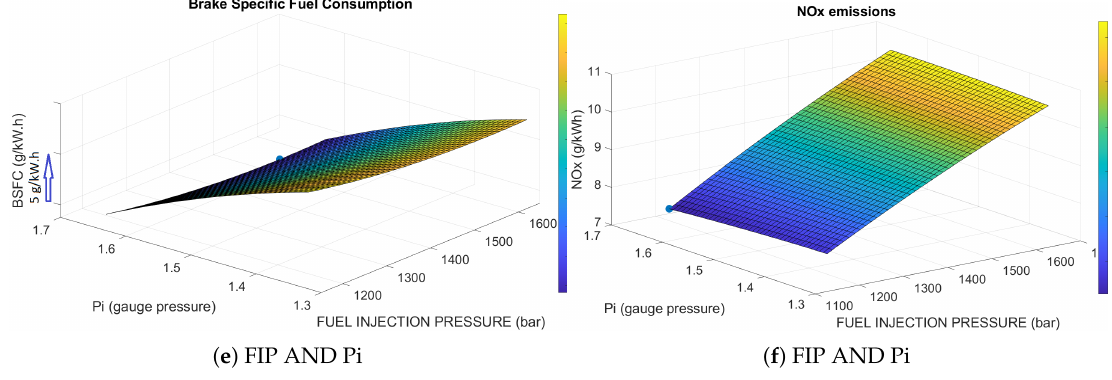
Figure A2. Response surface of the BSFC & NO x at 1000 RPM-400kW.